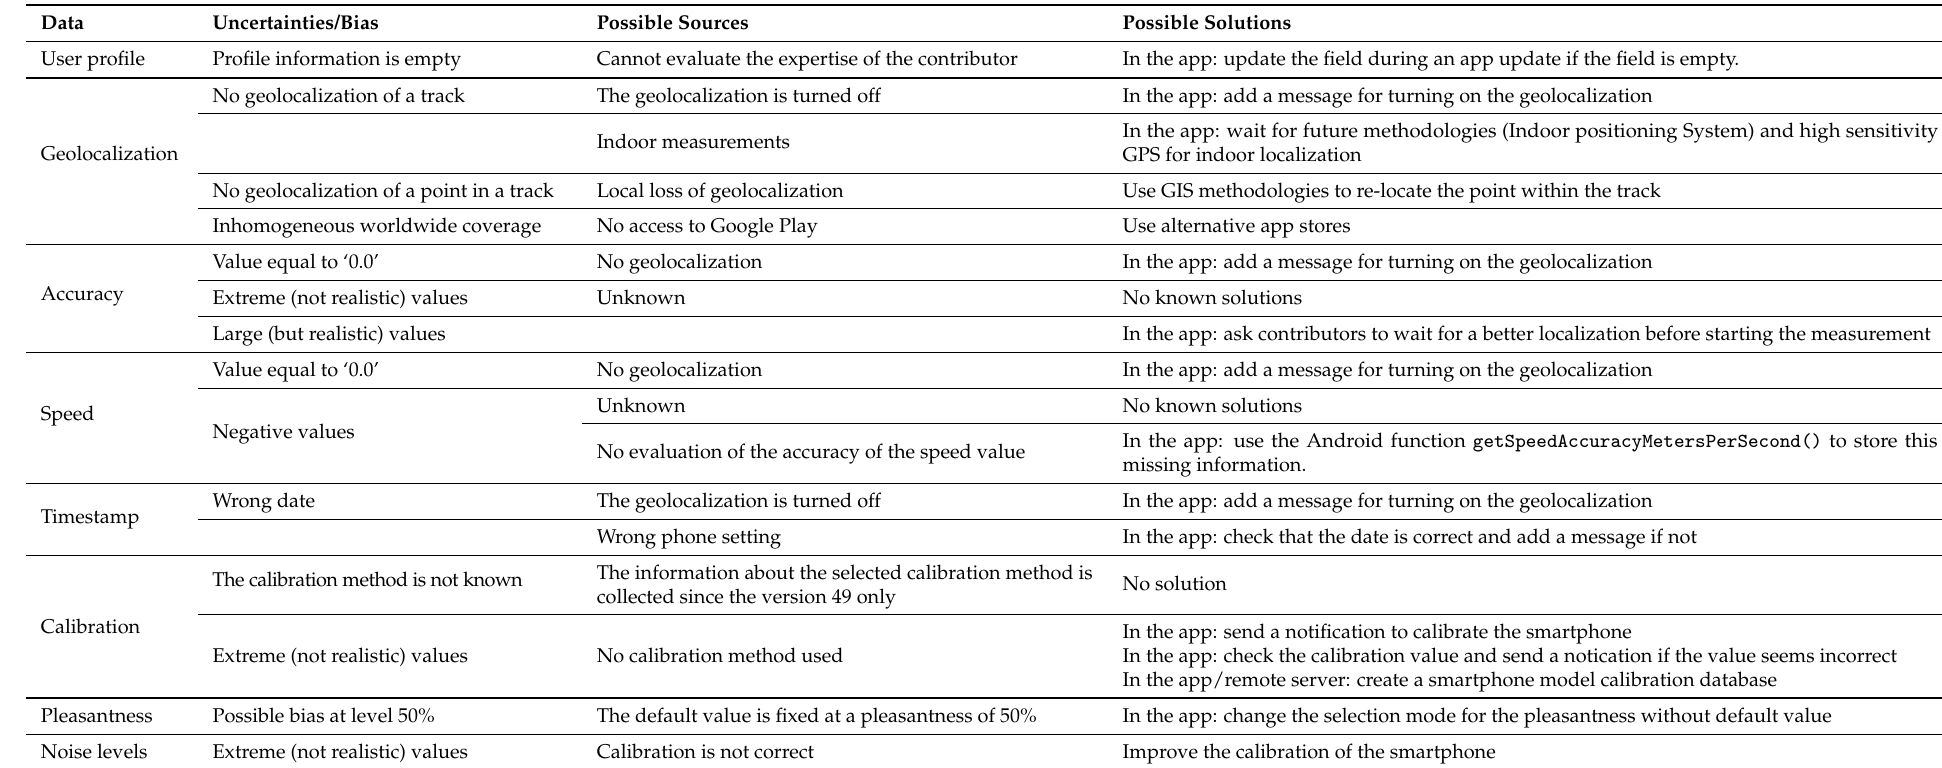
Table 20. Possible enhancements of the NoiseCapture application and